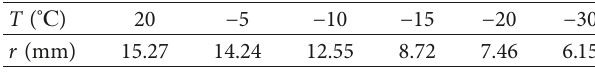
Figure 15: Mass percentage of different particle size fragments under different F-T Table 4: Particle size coefficients under different F-Ttemperatures.